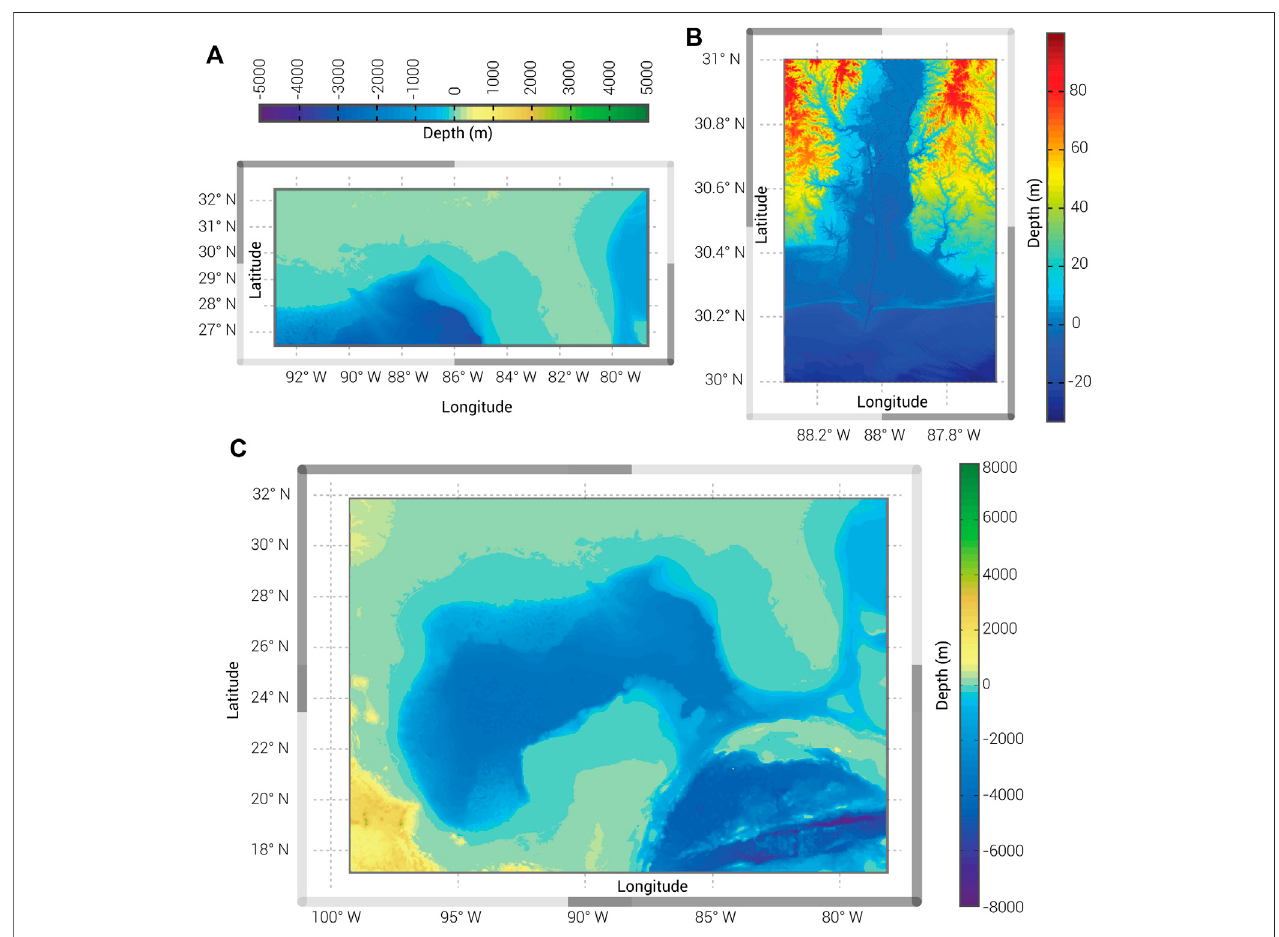
FIGURE 9 | Bathymetry and topography for the three nested domains used in this study: (A) NG domain, (B) MB domain, and (C) GOM domain.